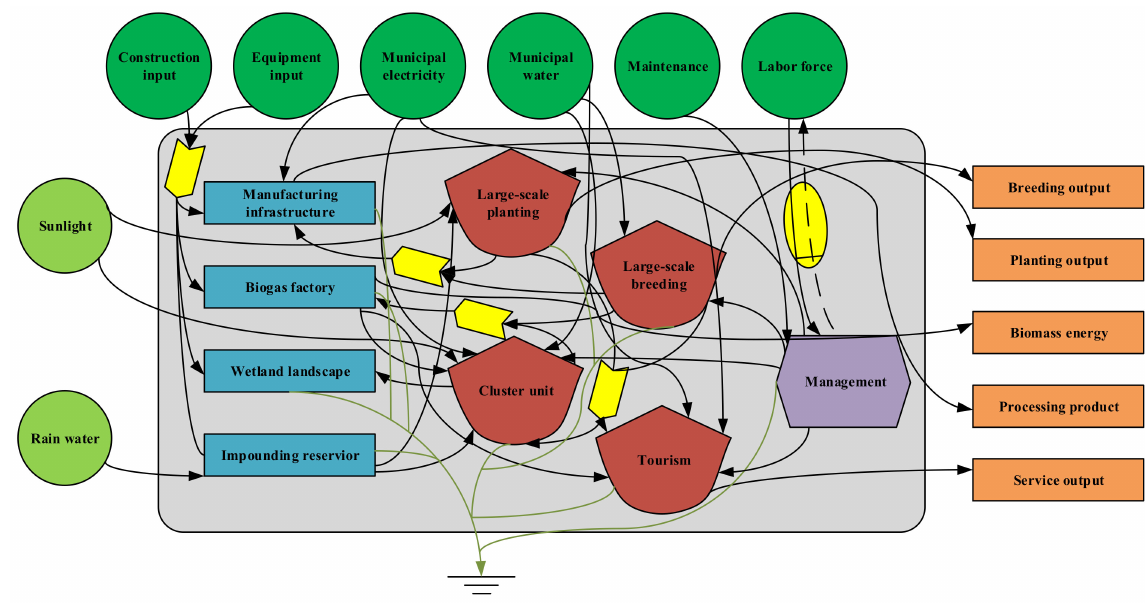
Figure 5. Energetic flow diagram of the village